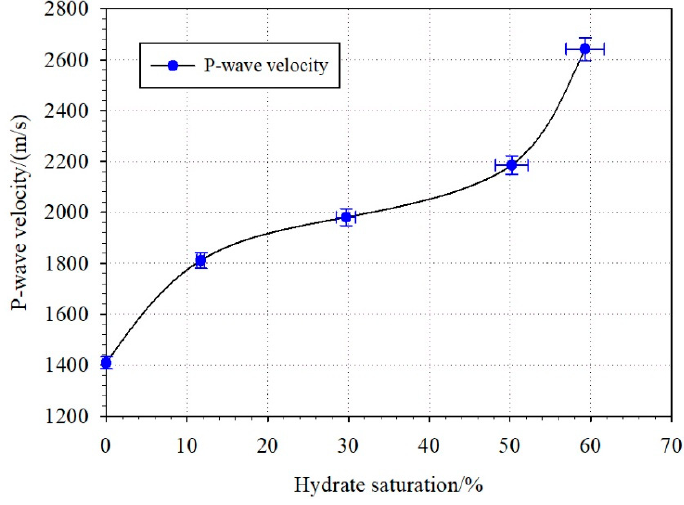
Figure 8. Variation of acoustic wave velocity with hydrate saturation during hydrate formation.